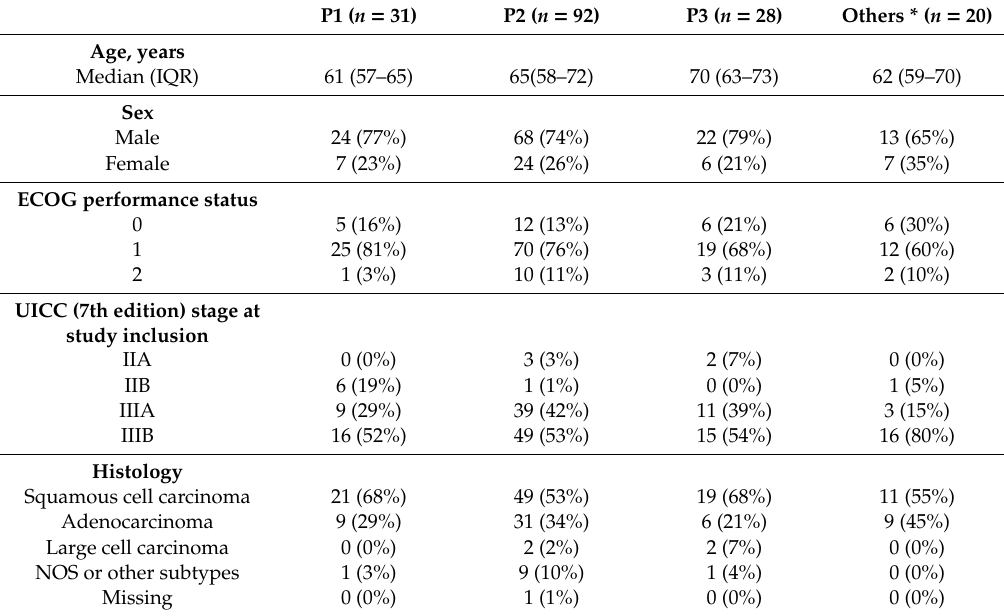
Table 1. Demographic and clinical details of the patients receiving chemoradiation according to di ff erent chemotherapy